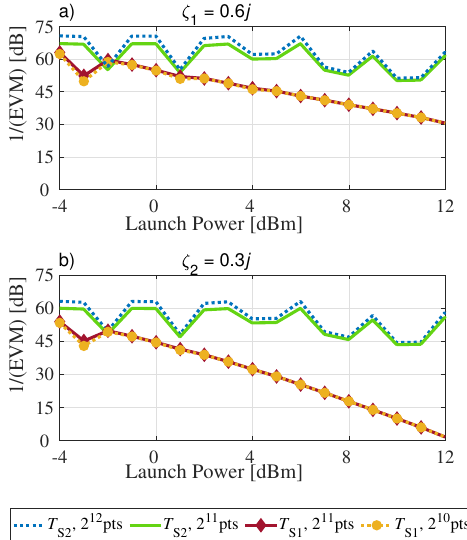
Figure 5. The reciprocal of the EVM of the baseline system as a function of the launch power when the system does not include any effects beyond those included in the ZSSP. ( a ) Results of signal decoded from the first eigenvalue ζ 1 = 0.6 j . ( b ) Results of signal decoded from the second eigenvalue ζ 2 = 0.3 j . Results are shown for the system with symbol period equal to T S1 and for the system with symbol period equal to T S2 = 2 T S1